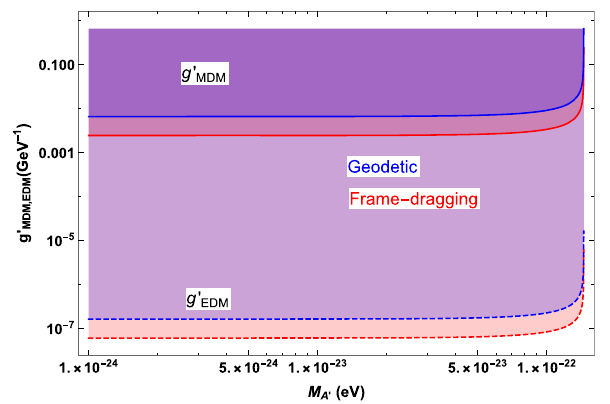
Fig. 4 Variation of dipole moment couplings g (cid:2) the dark photon mass m A (cid:2) from the geodetic (blue) and the frame- dragging (red) measurements using GP-B result. The shaded regions above these lines are